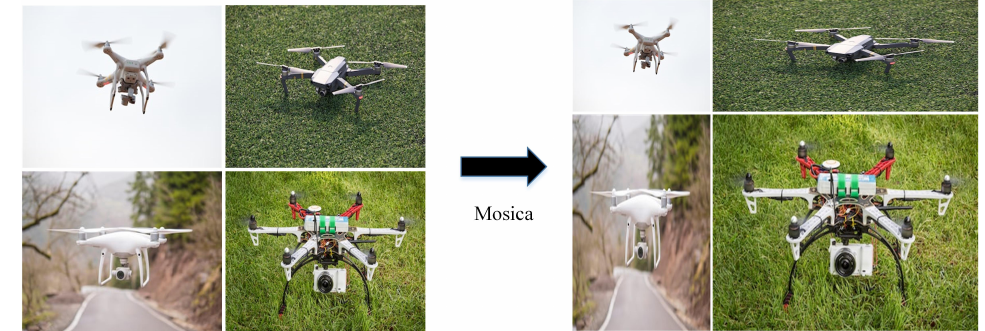
Figure 7. Example of Mosaic data augmentation. Left : The original image. Right : The processed image.